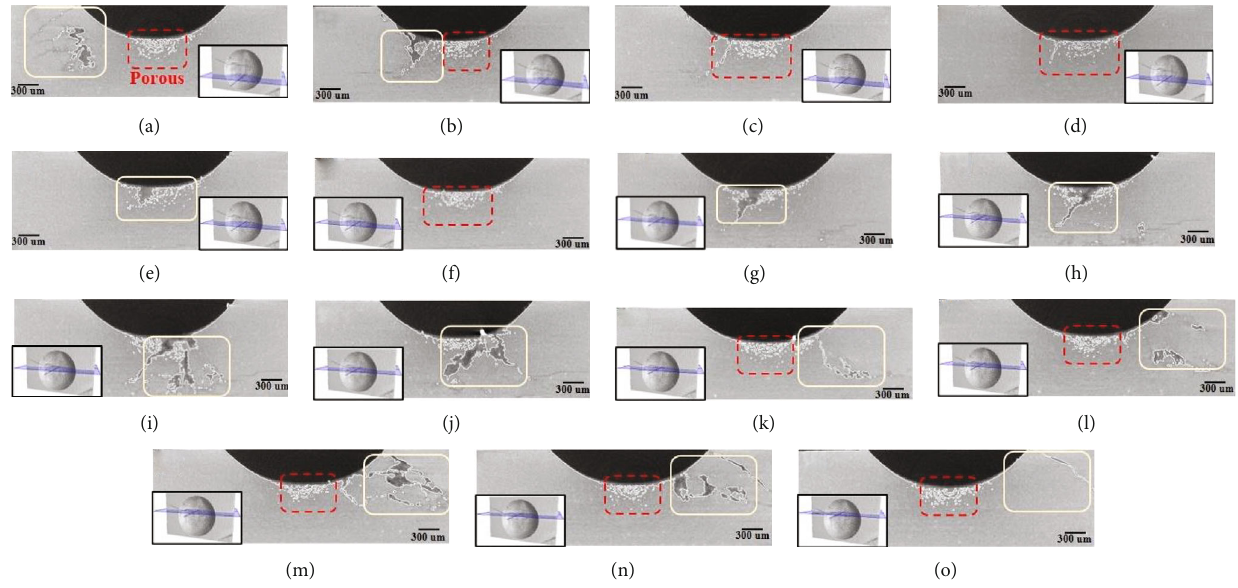
Figure 11: Vertical views in various scanning planes along the rolling direction.